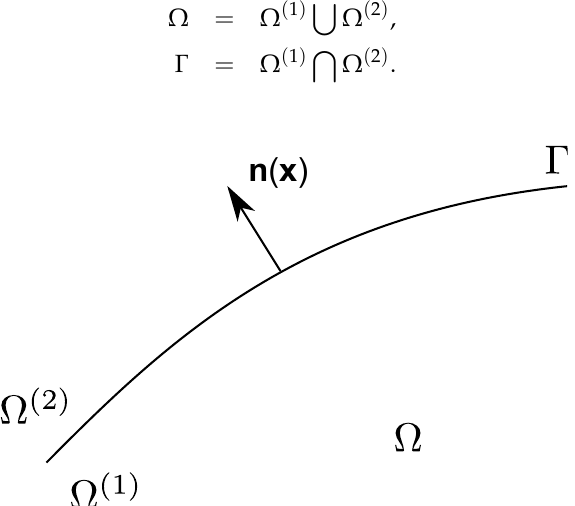
Figure 1. Subdomains Ω ( 1 ) and Ω ( 2 ) separated by interface Γ